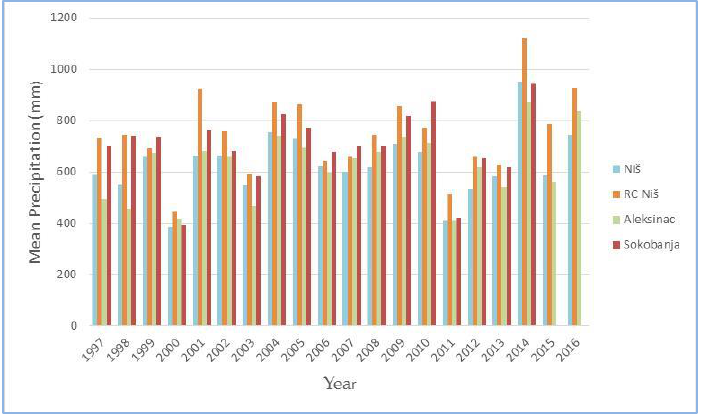
Figure 4 : Mean annual precipitation in the Niš region Figure 4. Mean annual precipitation levels in the Niš region from 1997 to 2016, obtained from four from 1997 to 2016, obtained from four meteorological stations. meteorological